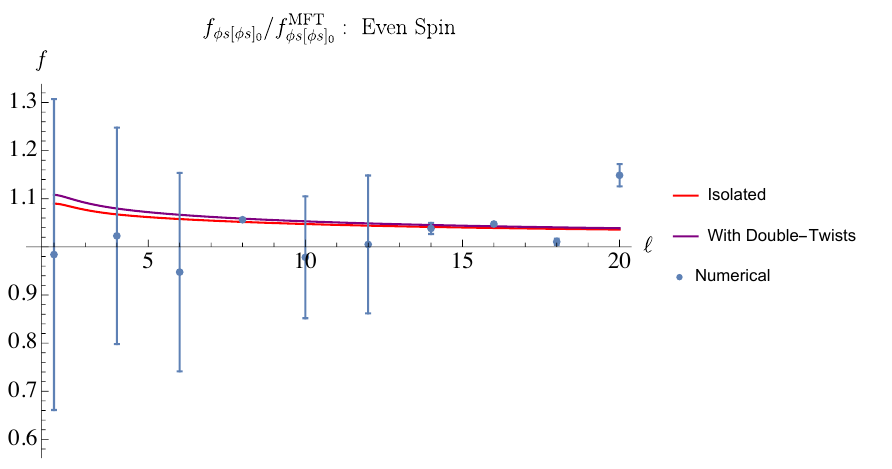
Figure 30 . The e(cid:11)ects of DTIs for low-lying double twists in the charge 1 odd-spin sector.